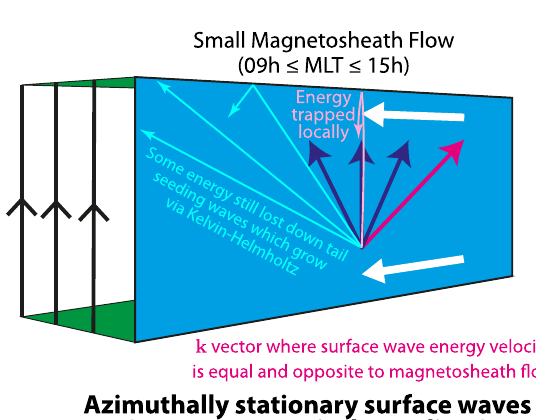
Fig. 8 Wave energy fl uxes tangential to the magnetopause. Panels show Poynting ( a ) and advective ( b ) energy fl uxes tangential to the magnetopause along magnetopause normals. Integrals along the normal are shown in panel c for the Poynting (purple) and advective (green) fl uxes along with their sum (black).